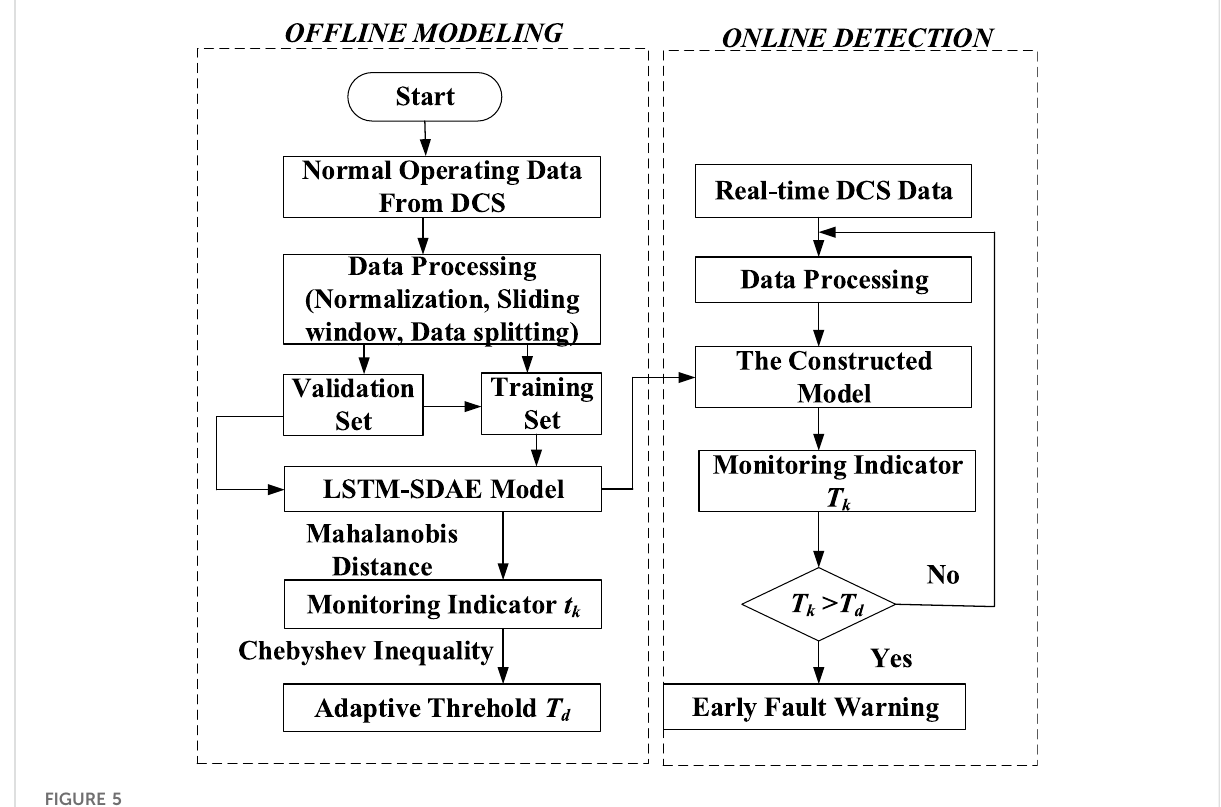
FIGURE 5 The fl ow chart of condition monitoring and early fault warning.